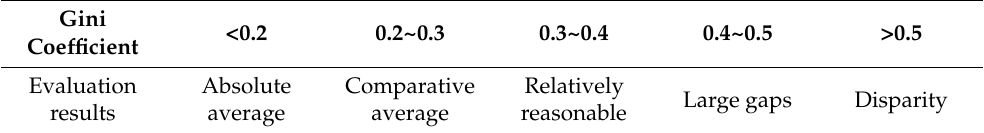
Table 1. Gini coefficient and evaluation